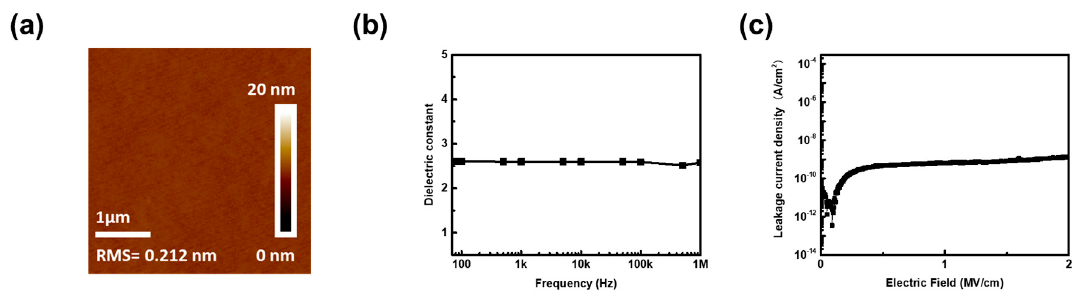
Figure 2. ( a ) AFM image, ( b ) dielectric constant value according to frequency, and ( c ) leakage current density under electric field of PI layers.